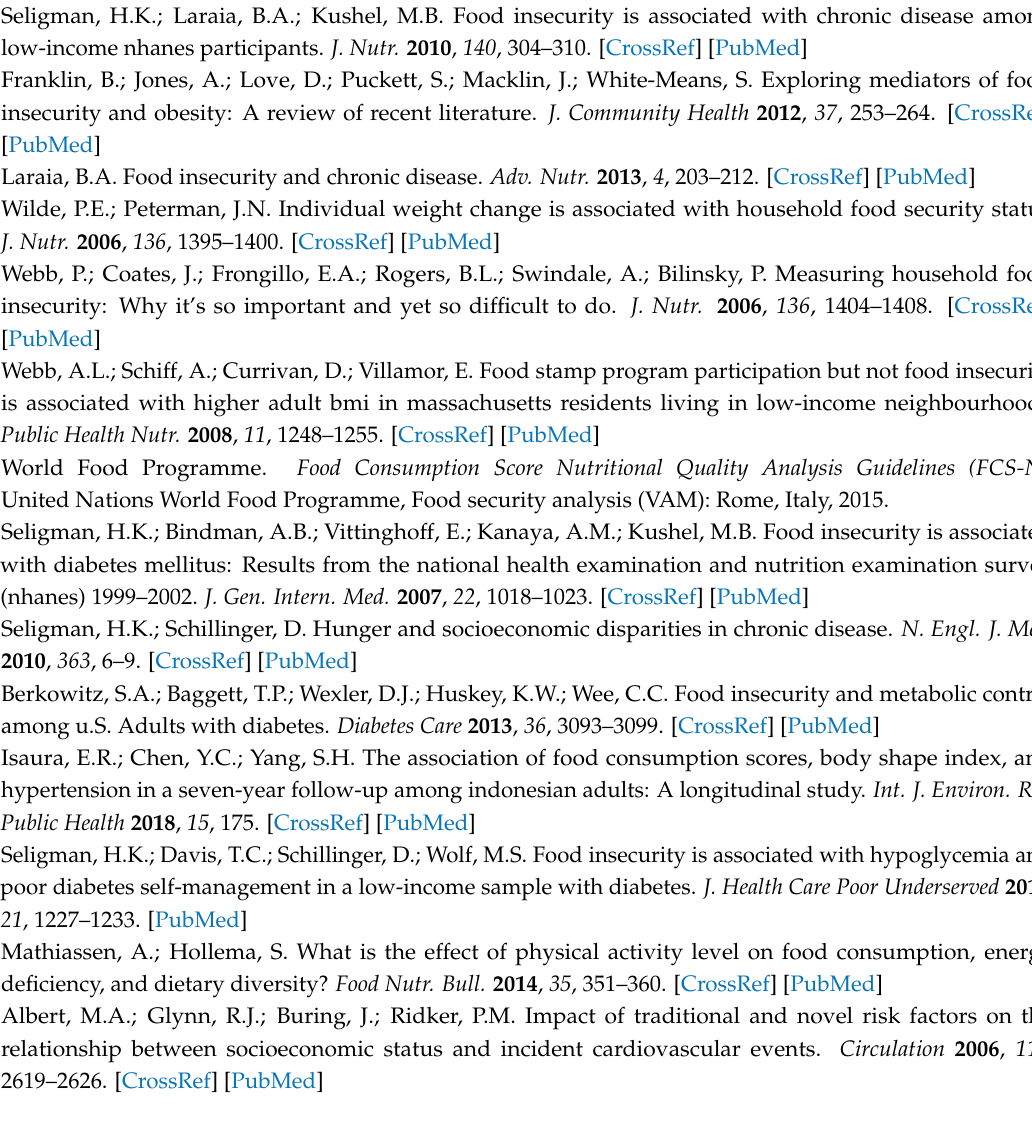
s1, Table S1: Direct and indirect effects of SEM variables on the cardiovascular